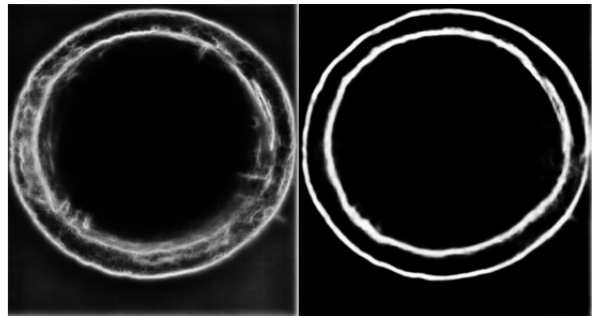
Figure 6. Comparison of the test results.